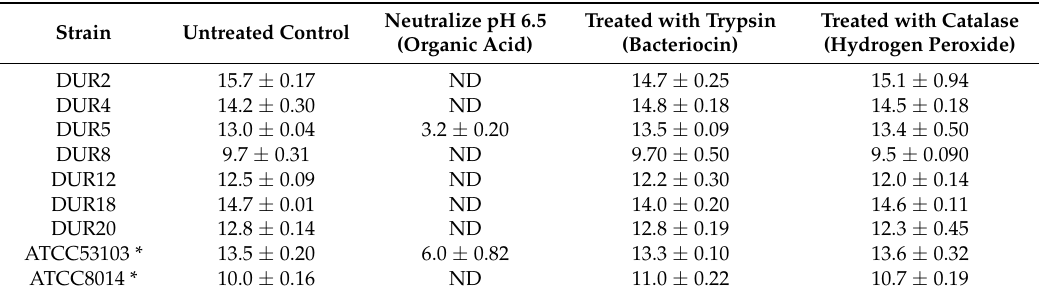
Table 7. Inhibitory activity of untreated and treated (trypsin, catalase, or adjusted to pH 6.5) Lactobacillus supernatants against E. coli 1